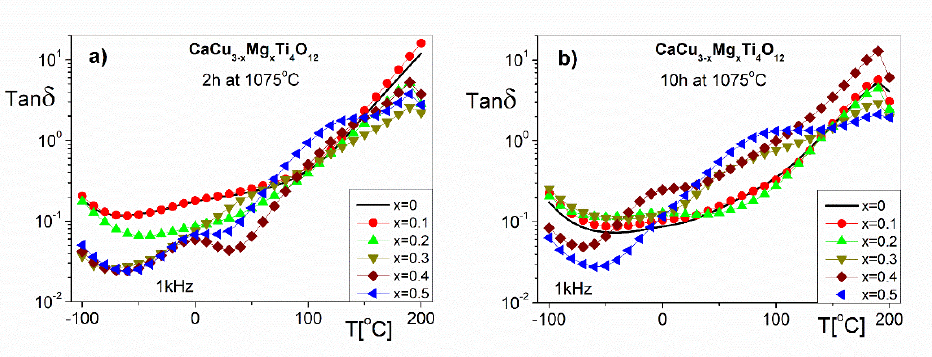
Figure 8. The temperature dependence of the loss angle tangent for CaCu 3−x Mg x Ti 4 O 12 sintered at 1075 °C for ( a ) 2 h and ( b ) for 10 h.